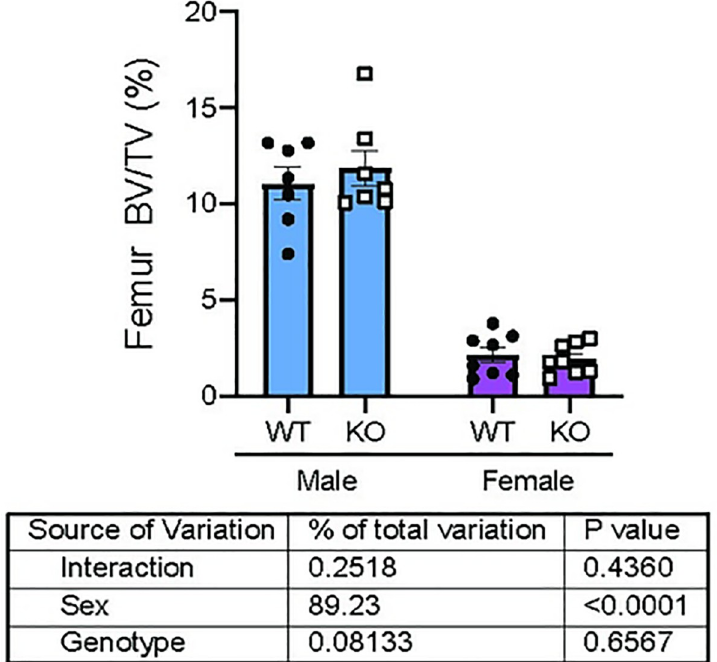
Fig 3. Trpm8 deletion did not overtly impact trabecular microarchitecture of the distal femur. Bone volume fraction (BV/TV) of the trabecular bone of the distal femur was measured in male and female Trpm8-KO and WT mice. N = 7–8 per group. Data are expressed as individual points with bars representing mean ± SEM. Table below the panel indicate results of the two-way ANOVA, with p- values for sex, genotype and their interaction. p -values above the bars represent results from Holm-Sidak post hoc test for pairwise significance after a significant interaction